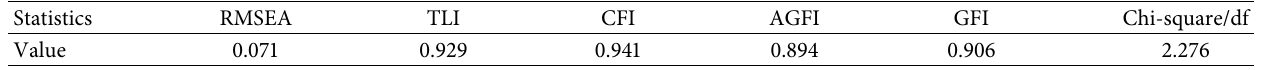
Table 7: Statistically ftted model of biomass energy development training in agriculture.